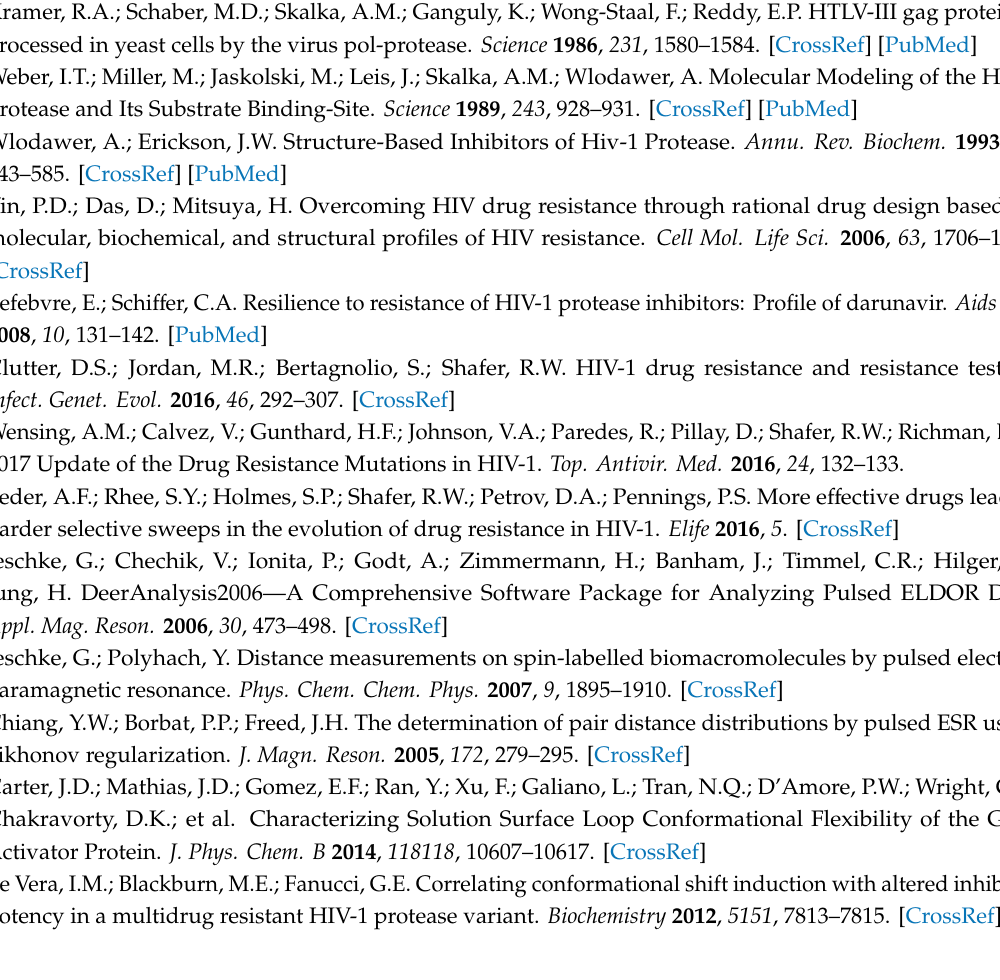
HIV-1 PR DRV2, pH 5.0. Figure S11: DEER data for apo HIV-1 PR DRV3, pH 5.0. Figure S12: DEER data for apo HIV-1 PR DRV3, pH 3.0. Figure S13: DEER data for CaP2-bound HIV-1 PR DRV3, pH 5.0. Figure S14: DEER data for DRV-bound HIV-1 PR DRV3, pH 5.0. Figure S15: DEER data for apo HIV-1 PR DRV4, pH 5.0. Figure S16: DEER data for CaP2-bound HIV-1 PR DRV4, pH 5.0. Figure S17: DEER data for DRV-bound HIV-1 PR DRV4, pH 5.0. Figure S18: DEER data for apo HIV-1 PR DRV5, pH 5.0. Figure S19: DEER data for CaP2-bound HIV-1 PR DRV5, pH 5.0. Figure S20: DEER data for DRV-bound HIV-1 PR DRV5, pH 5.0. Figure S21: DEER data for apo HIV-1 PR DRV6, pH 5.0. Figure S22: DEER data for CaP2-bound HIV-1 PR DRV6, pH 5.0. Figure S23: DEER data for DRV-bound HIV-1 PR DRV6, pH 5.0. Table S2: DEER population analysis via Gaussian reconstruction. Table S3: Relative Populations of Conformational States Determined from DEER Analysis. Table S4: Z-test for Evaluating the Di ff erence in the Semi-open Population Relative to Subtype B. Table S5: Z-test for Evaluating the Di ff erence in the Open-Like = Wide-Open + Curled Populations Relative to Subtype B. Table S6: Z-test for Evaluating the Di ff erence in the Closed Populations Relative to Subtype B Figure S24: Analysis of significance of population di ff erences for conformational sampling of DRV constructs relative to Subtype